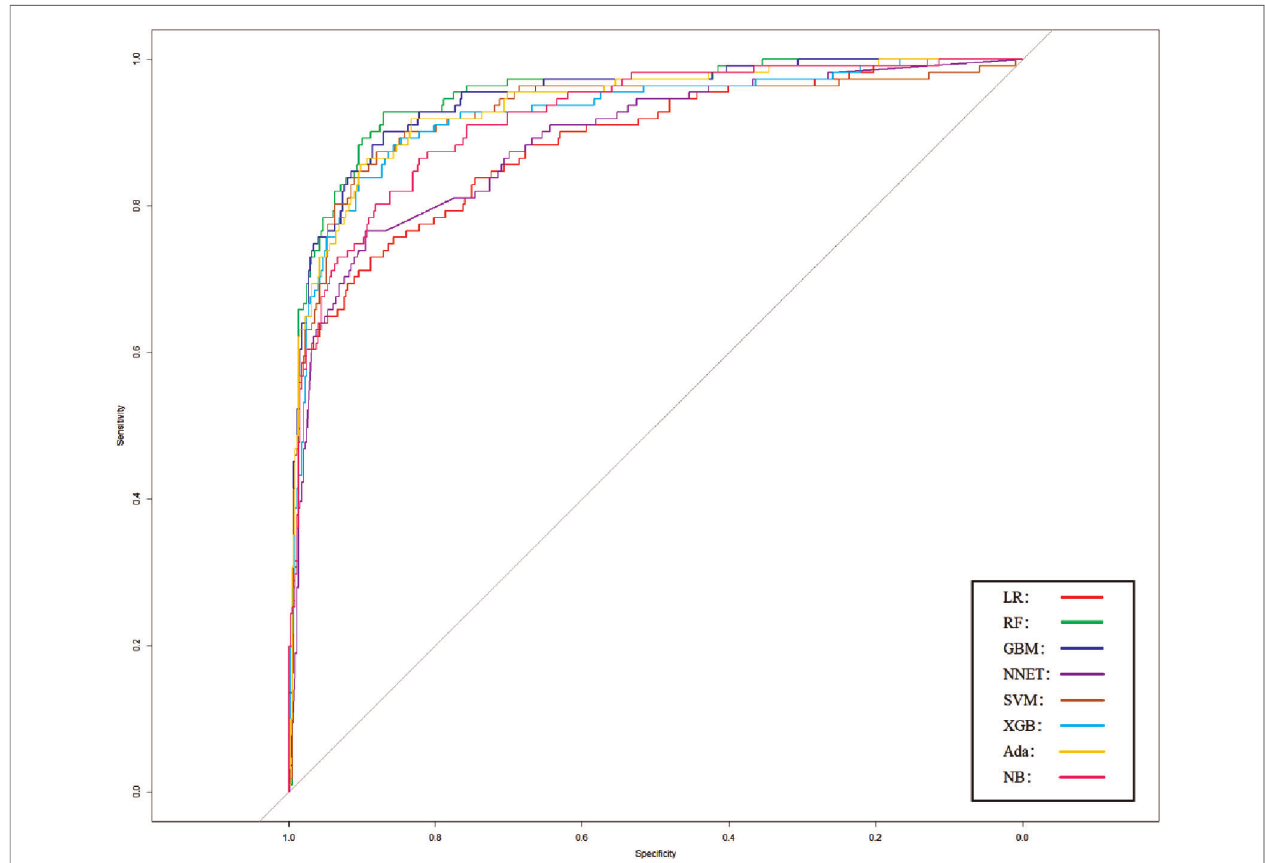
FIGURE 3 | Area under receiver operating characteristic curve by different Model1 algorithms in the validation cohort. LR, logistic regression; RF, random forest; GBM, gradient boosting machine; NNET, arti fi cial neural network; SVM, support vector machine; XGB, eXtreme gradient boosting; Ada, adapting boosting; NB, naïve Bayes; Model1 was adjusted for GCS, glucose, sodium, chloride, SPO 2 , bicarbonate, temperature, white blood cell (WBC), heparin use, and SOFA score.